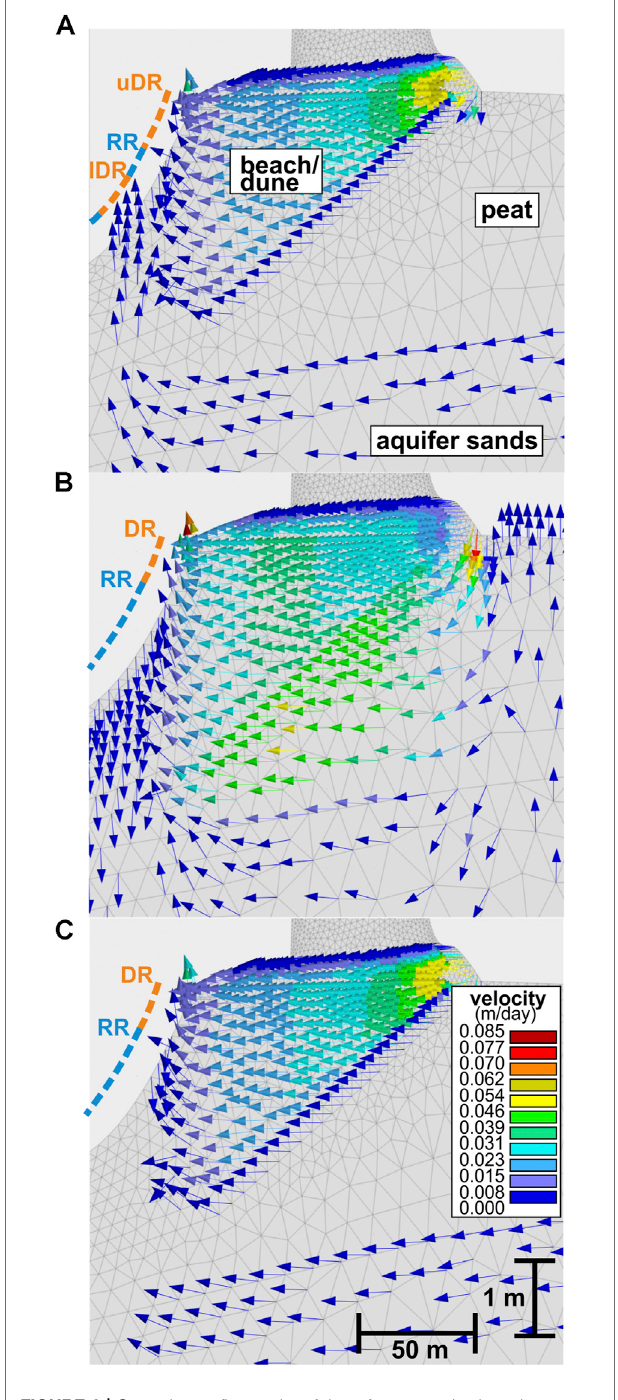
FIGURE 3 | Groundwater fl ow paths of the reference and selected scenarios illustrated using velocity vectors, in subset of the modelling domain. From top to bottom: (A) reference (B) peat K s max, (C) peat extension max. Discharge (DR) and recharge regions (RR) are indicated with orange and blue dashed lines, respectively. The upper (uDR) and lower (lDR) discharge regions are shown in panel 3A.